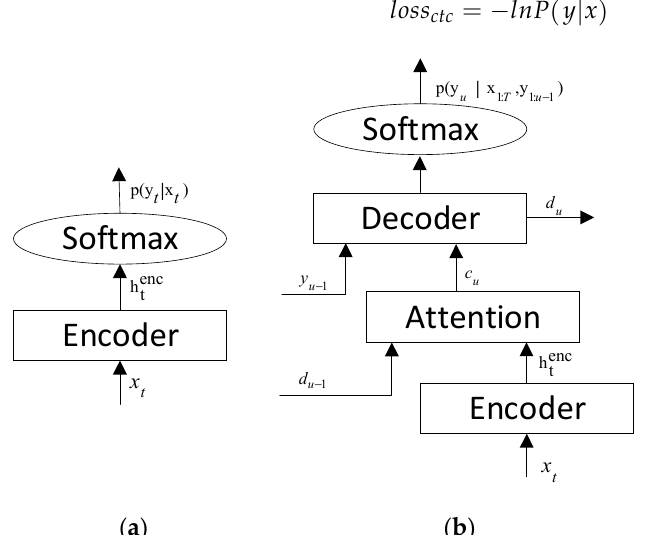
Figure 3. The structure diagram of the two main end-to-end models. ( a ) The architecture of connec- tionist temporal classification (CTC); ( b ) the architecture of attention-based encoder–decoder (AED) model.